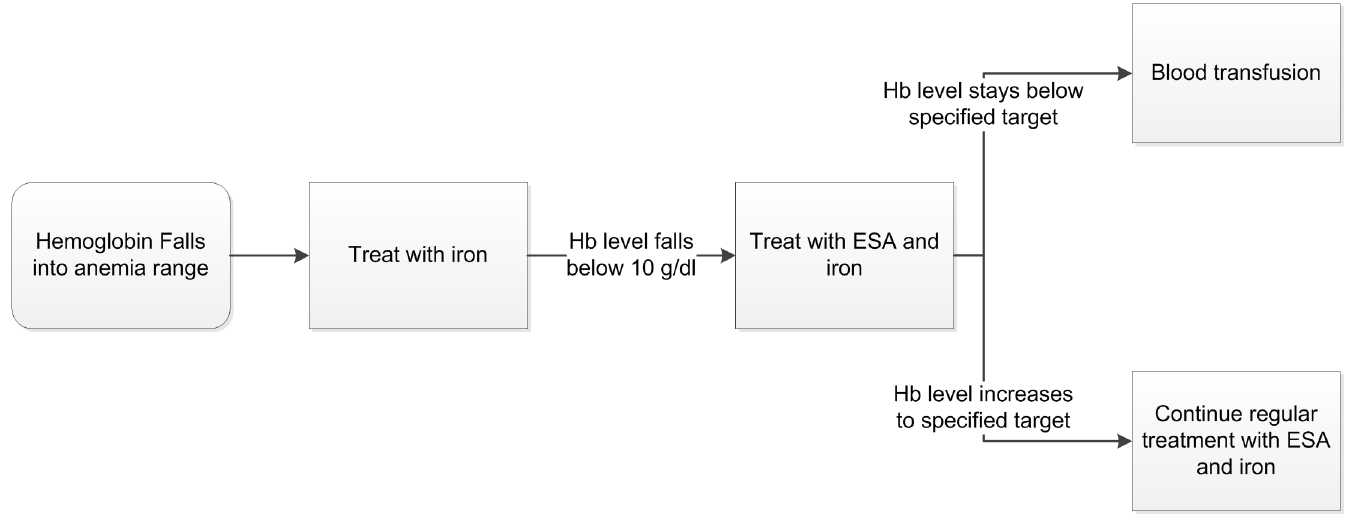
Fig 1. Annualized anemia treatment decision flowchart assumed in the CKD Policy